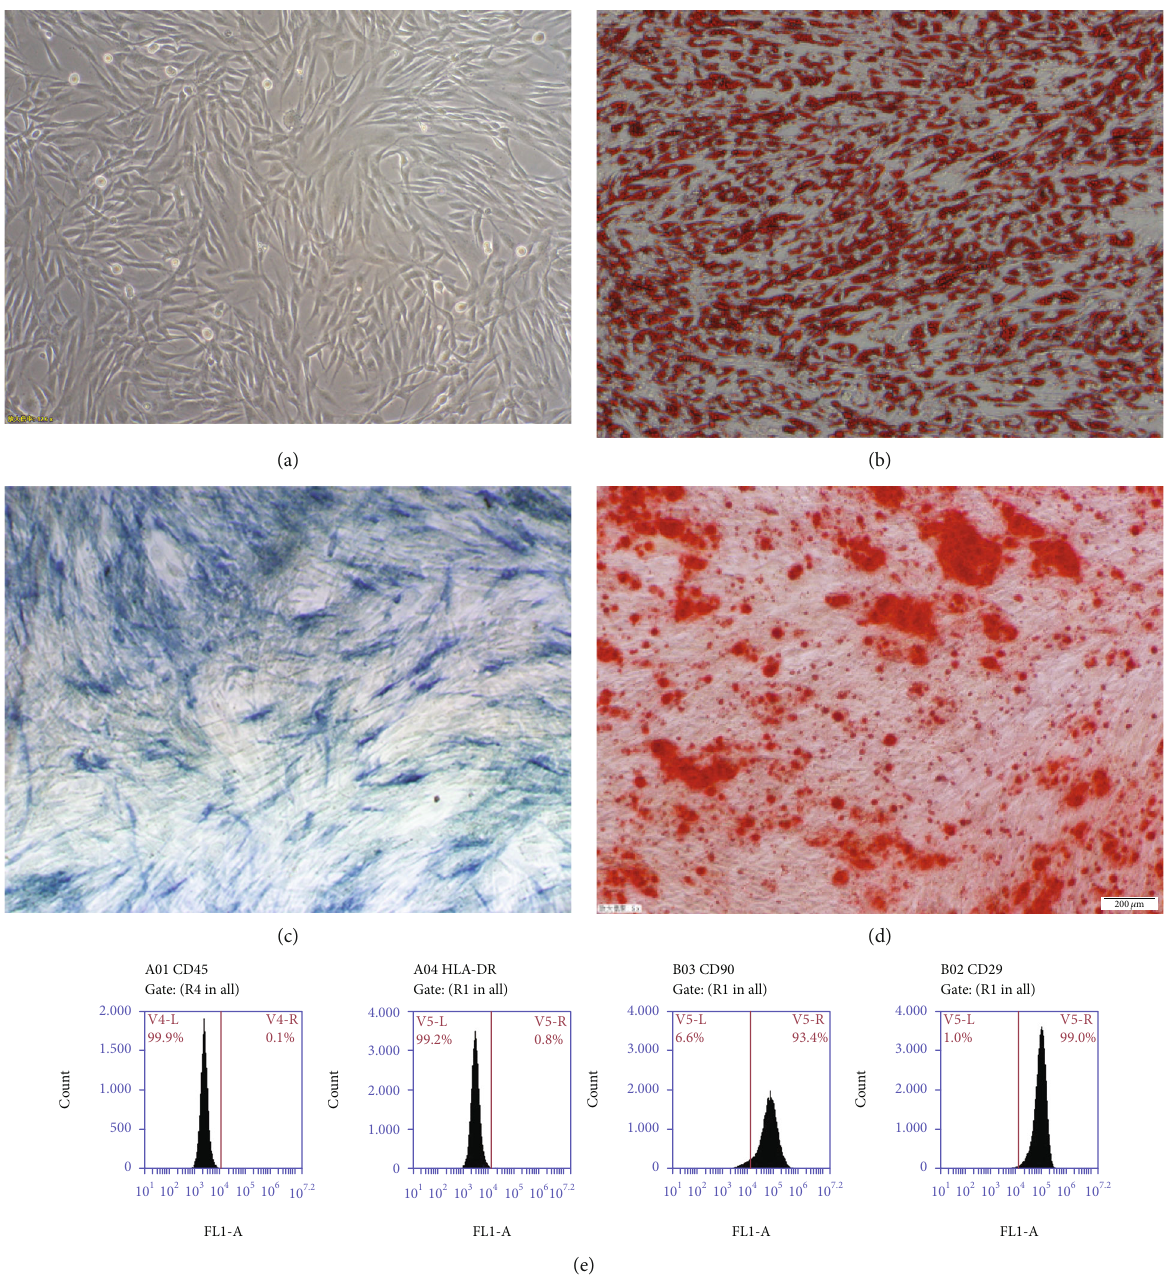
Figure 2: Morphology and identi fi cation of ADSCs. (a) Morphology of ADSCs under a light microscope. (b) Oil Red O staining results on the 11th day of adipogenic di ff erentiation. (c) ALP staining results on the 6th day of osteogenic di ff erentiation. (d) Alizarin Red staining results on the 12th day of osteogenic di ff erentiation. (e) Identify its phenotype by fl ow